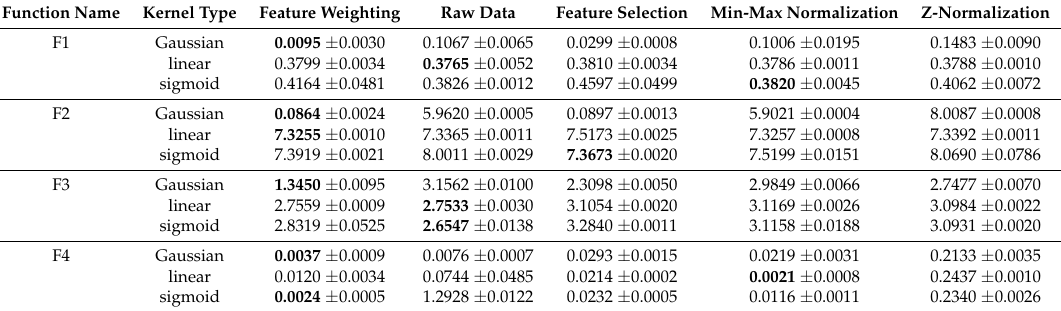
Table 4. Performance comparison of SVR modeling for the synthetic datasets.